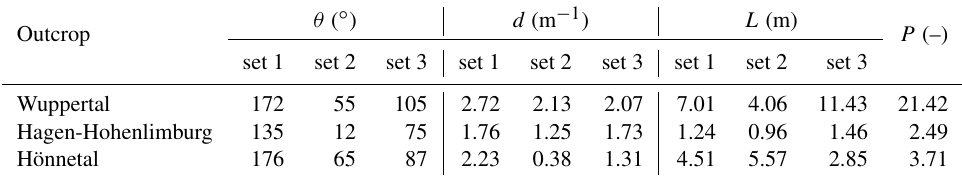
Table 6. Overview of the 2D discontinuity connectivity